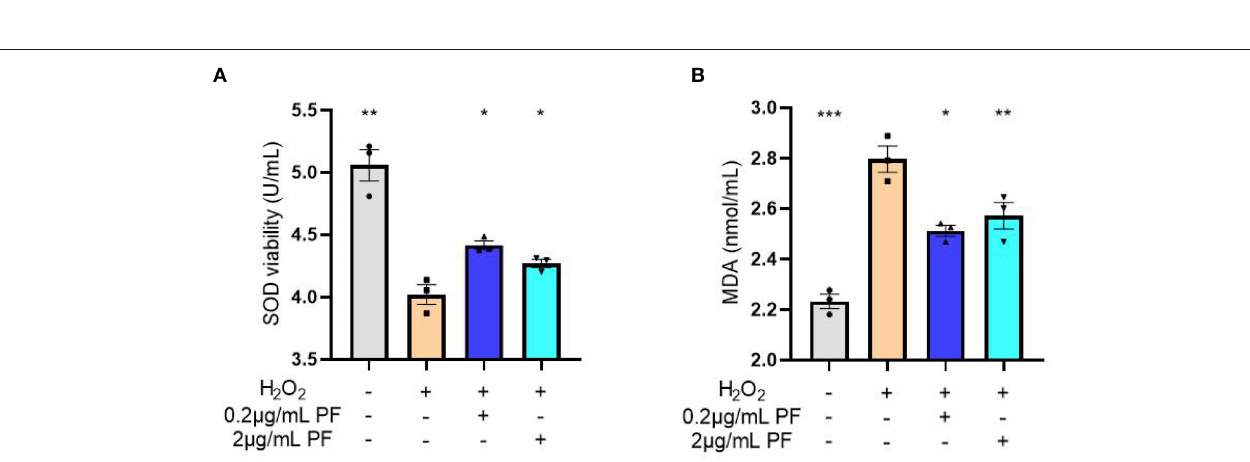
FIGURE 5 | Paeoniflorin (PF) restored oxidative stress marker levels in the neurons exposed to hydrogen peroxide. (A) The superoxide dismutase (SOD) activities were significantly reduced after hydrogen peroxide exposure in the neurons ( P < 0.01). However, pretreated with 0.2 µ g/ml ( P < 0.05) and 2 µ g/ml ( P < 0.05) PF in the damaged neurons significantly restored SOD activities. (B) The increased MDA levels in the primary cultured neurons caused by hydrogen peroxide exposure were significantly inhibited by pretreatment with 0.2 µ g/ml ( P < 0.05) and 2 µ g/ml ( P < 0.01) PF. Three-way ANOVA statistics: F A = 32.13, P < 0.001; F B = 31.76, P < 0.001. Values are the mean ± SEM, n = 3/group. * p < 0.05, ** p < 0.01, *** p <